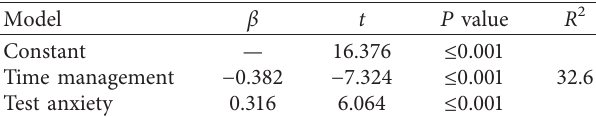
Table 4: Summary of the regression models predicting academic procrastination as the dependent